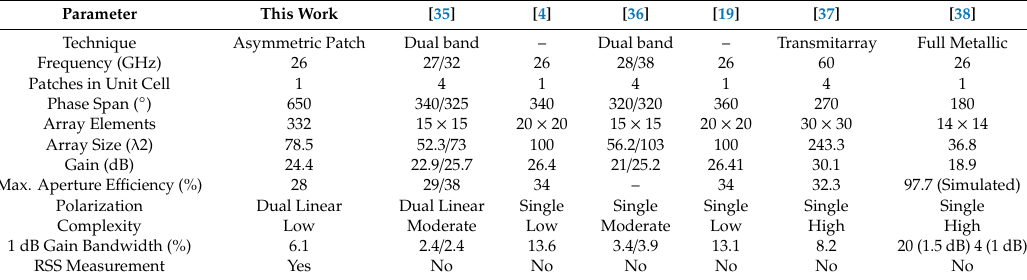
Table 3. Performance comparison of asymmetric patch reflectarray antenna with other related works. Parameter This Work [35]